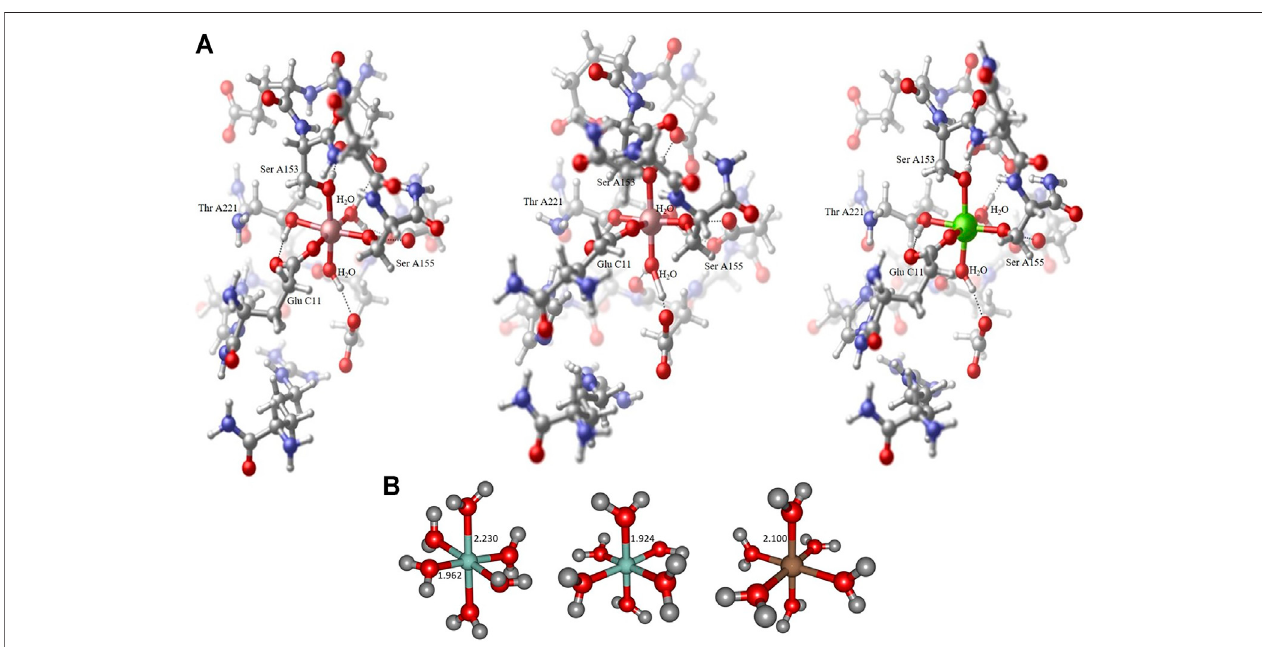
FIGURE 1 | Collagen-integrin model complex containing a Co 2+ center in a Jahn-Teller distorted octahedral ligand sphere (left), model complex containing a Co 3+ center in an almost perfect octahedral ligand sphere (center) and model complex containing a Mg 2+ center in an almost perfect octahedral ligand sphere (right). All structures obtained at the B3LYP/6-31G* level of theory, hydrogen bond interactions to adjacent amino acid residues indicated by dotted lines. The Collagen-integrin modelcomplexcontainstheaminoacidsAspA151,GluA152,SerA153,AsnA154,SerA155,ThrA221,AspA254,GlyA255,GluA256,SerA257,HisA258,Arg B12 und Glu C11 and two water molecules of the structure 1DZI (37). The direct ligands on the divalent metal ions are Ser A153, Ser A155, Thr A221, Glu C11 and two water molecules (A) . Hexaaqua model complex containing a Co 2+ center in a Jahn-Teller distorted octahedral ligand sphere of water molecules, axial R Co − O distance 2.230 Å, equatorial R Co − O distances 1.962 − 1.967 Å (left), hexaaqua model complex containing a Co 3+ center in an almost perfect octahedral ligand sphere of water molecules, all R Co − O distances 1.924 Å (center) and hexaaqua model complex containing a Mg 2+ center in an almost perfect octahedral ligand sphere of water molecules, all R Mg − O distances 1.924 Å (right). All structures obtained at the B3LYP/6-31G* level of theory (B)